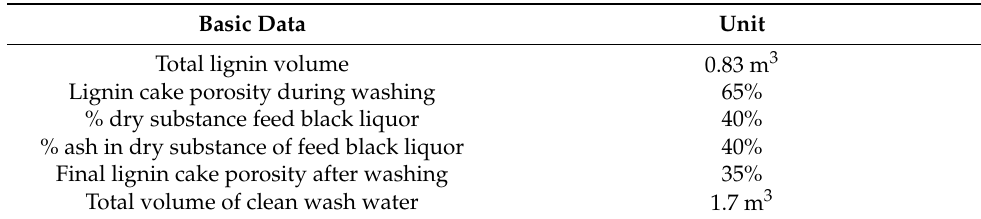
Table 1. Basic data for calculation of the washing efficiency for the LignoForce, LignoBoost, and SLRP process.